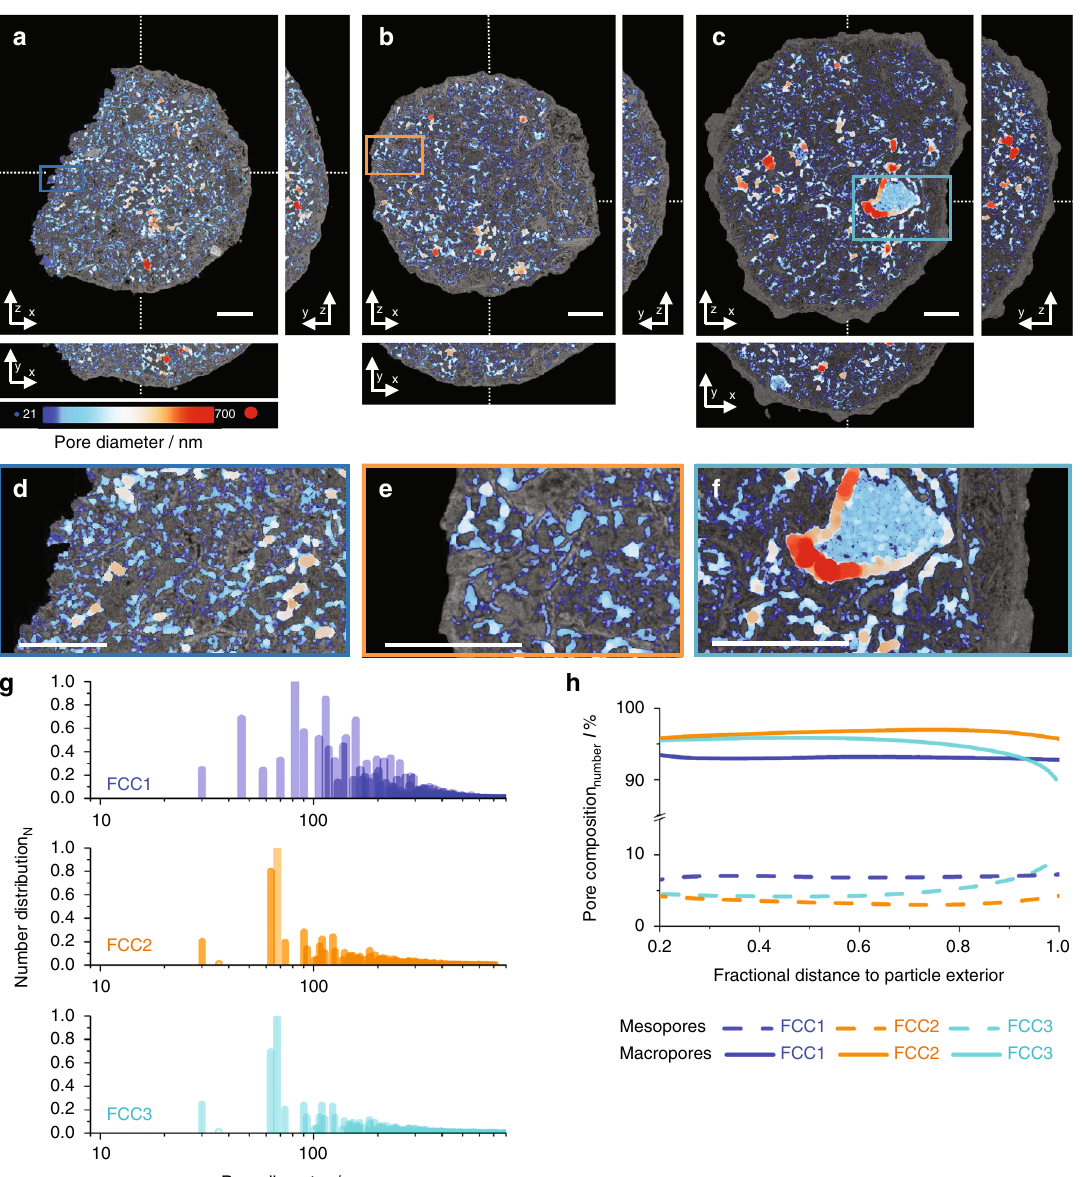
Fig. 5 Pore network and pore size distribution analysis. Calculated thickness or pore diameter maps of FCC1, FCC2, and FCC3 are presented in a – c , respectively. Presented are bottom up ( z – x ) and orthogonal views ( y – z , y – x ). Cutting planes are represented by dotted lines . Orthoslices are presented in overlay of electron density reconstructions (Fig. 2). The diameter of the fi tted spheres is represented by a color map, ranging from 21 ( blue ) to 700 nm ( red ). Shown in d – f are enlarged versions of selected areas. Scale bars are 5 µ m. g Thickness map-derived pore size distribution (PSD). h Radial